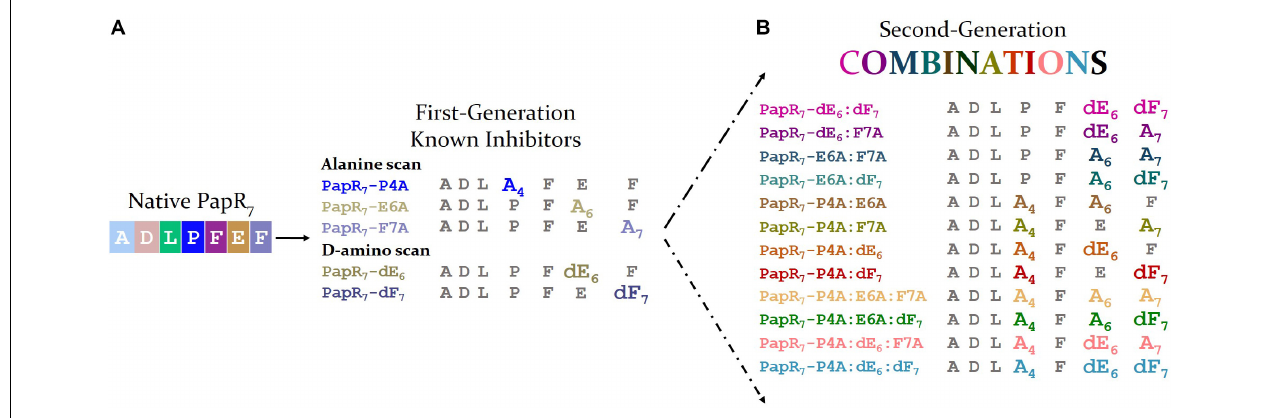
FIGURE 1 | Second generation of PapR 7 -derived peptide combinations. (A) Sequences of first generation potent synthetic inhibitors 7-mer PapR-derived peptides (PapR 7 ; ADLPFEF) involved D -amino acid or alanine replacements at three positions; proline (P) glutamic (E), and phenylalanine (F) of the heptapeptide PapR. (B) Sequences of second generation of PapR 7 -derived peptide combinations, involved double and triple alanine and D -amino acids replacement.